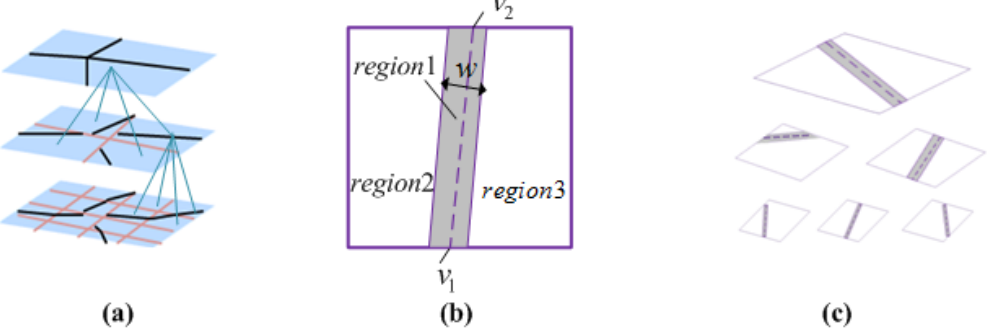
Figure 3. Segmentation procedures. ( a ) A multi-scale pyramid; ( b ) a mask for MLFD; and ( c ) masks applied for each